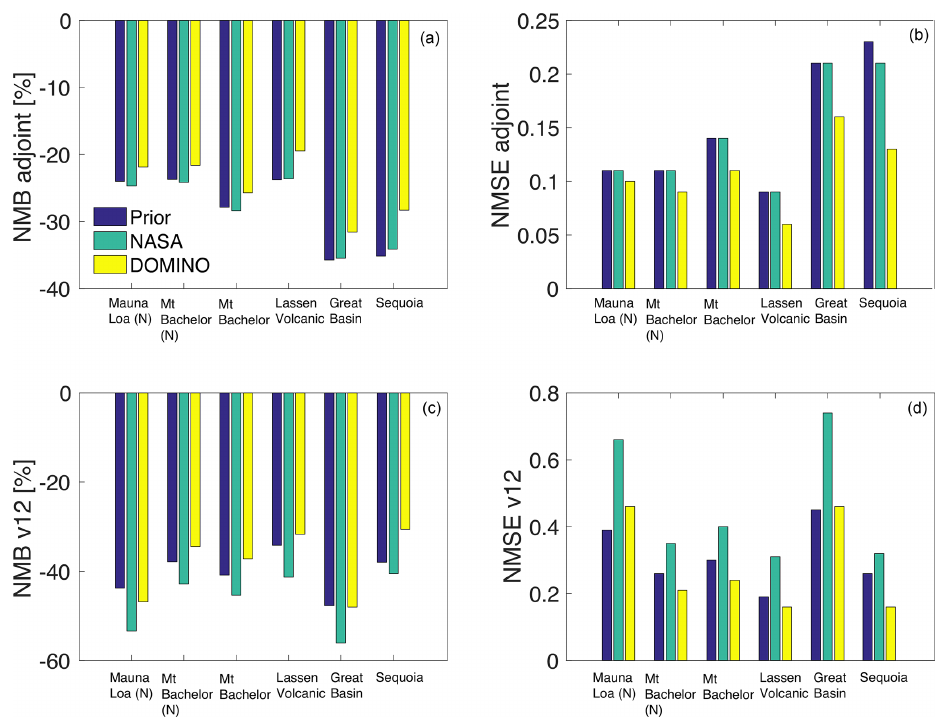
Figure 11. NMSE and NMB of GC-adj (a, b) and GCv12 (c, d) ozone simulations in 2010–2014 evaluated with surface measurements at remote sites. Three sets of NO x emissions, i.e., bottom-up inventory (HTAP for GC-adj, CEDS for GCv12), DOMINO posterior emissions, and NASA posterior emissions, are input in each model. Site names with “(N)” represent nighttime. The rest are comparisons at daytime.